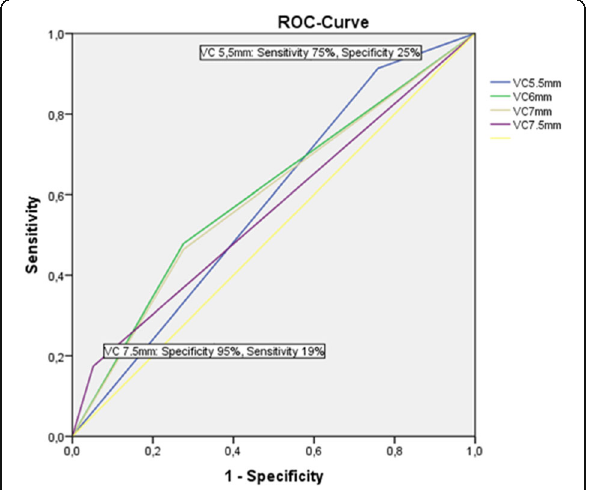
Fig. 1 ROC curve shows the sensitivity and specificity of the different cutoff levels of VC to predict the use of multiple